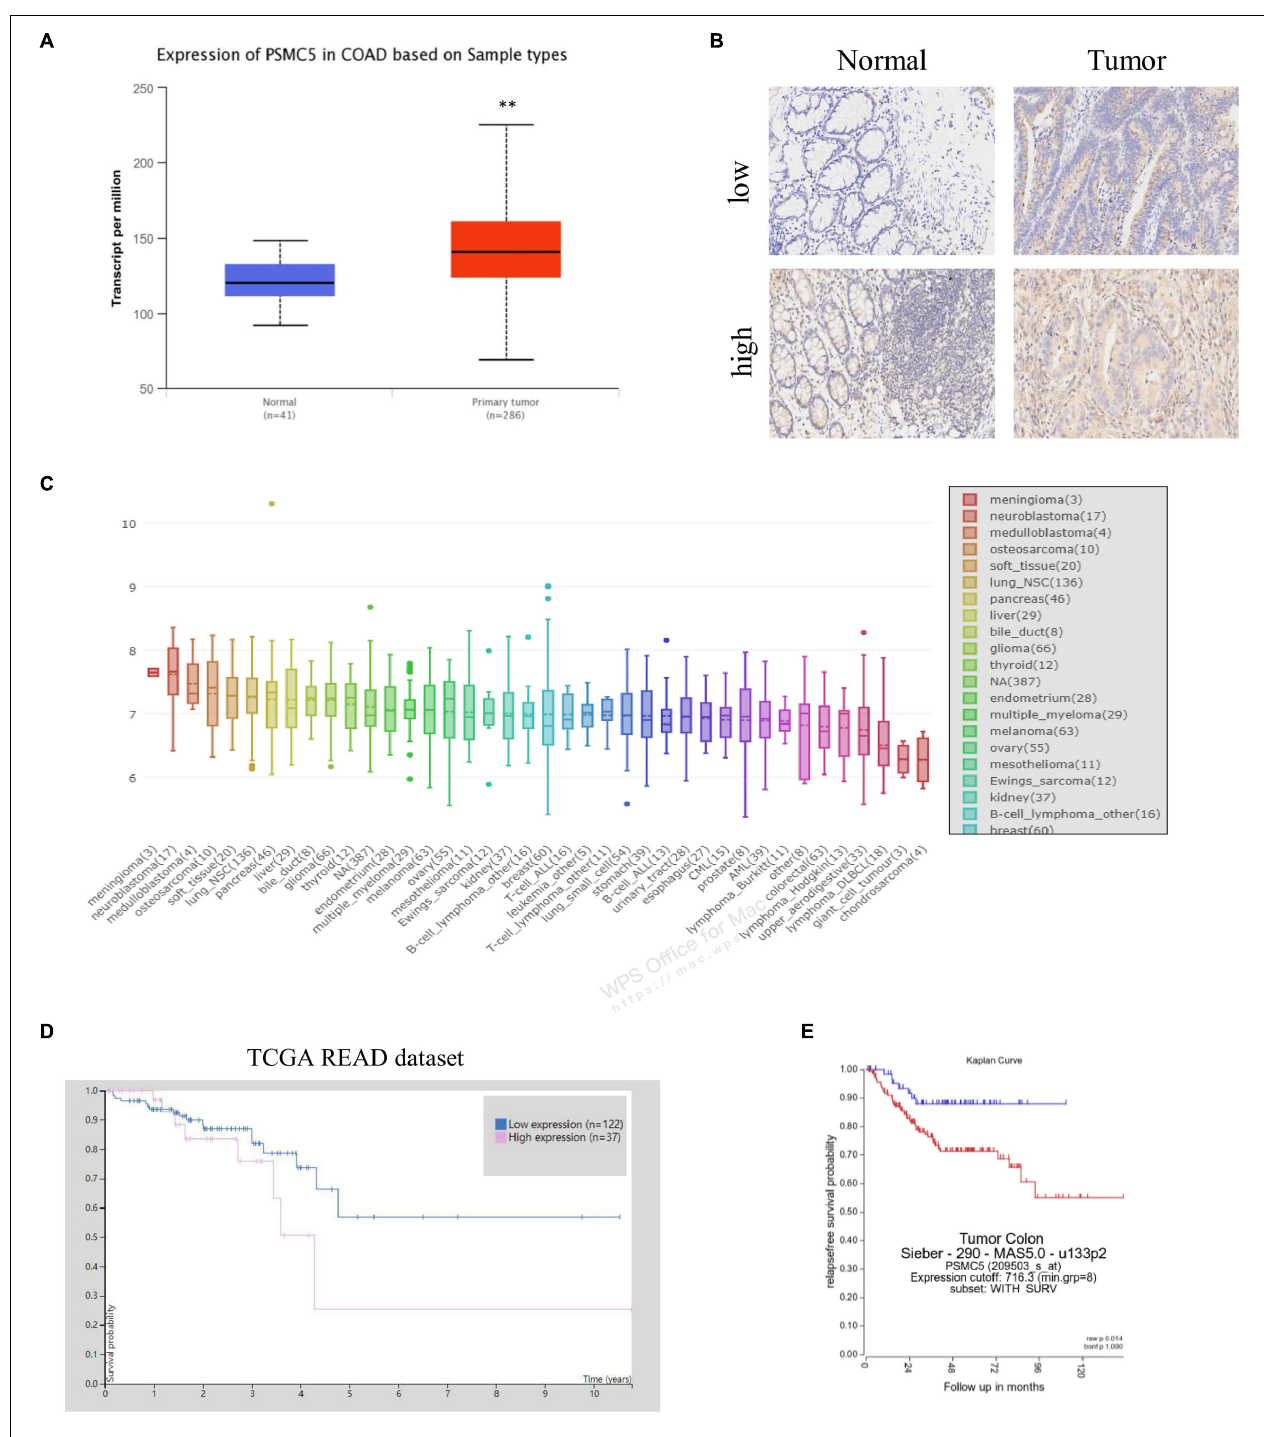
FIGURE 1 | The expression of PSMC5 was significantly elevated in CRC tissues. (A) Expression level of PSMC5 in TCGA colon adenocarcinoma dataset. p values were calculated by Student’s t -test. ** p < 0.01. (B) Representative IHC images of PSMC5 in CRC tissues and the paired normal tissues. (C) Expression of PSMC5 across multiple human cancer cell lines. (D,E) The Kaplan–Meier analysis of patients with high or low expression of PSMC5 in TCGA rectal adenocarcinoma (READ) and an independent colon cancer patient cohort [ p = 0.01 (D) and p = 0.014 (E) , respectively]. CRC, colorectal cancer; TCGA, The Cancer Genome Atlas; and IHC,